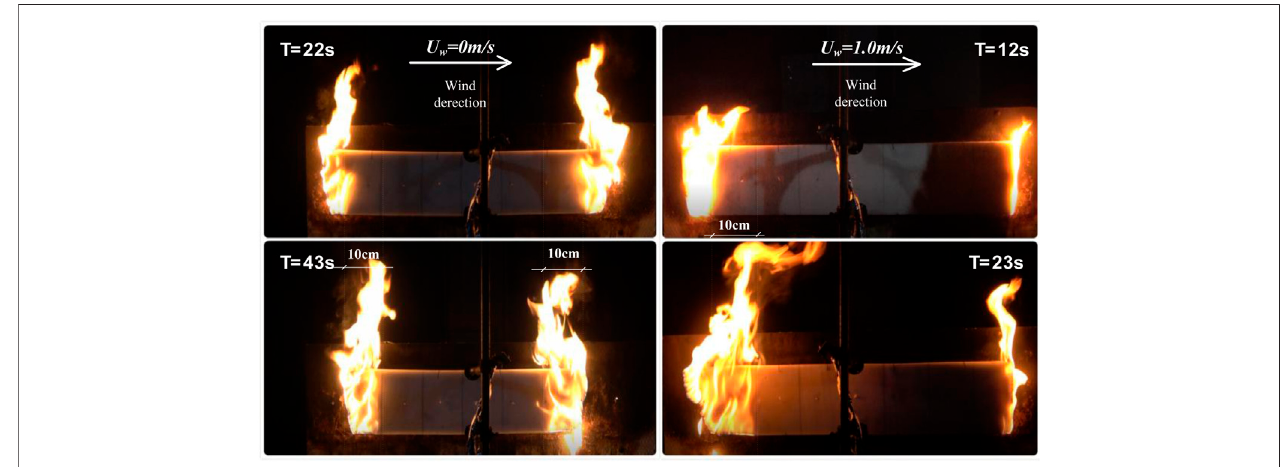
FIGURE 7 | Photographic images showing the comparison of the time required for the same intervals (10 cm) of fl ame migration in the different zones of FPU boards at U